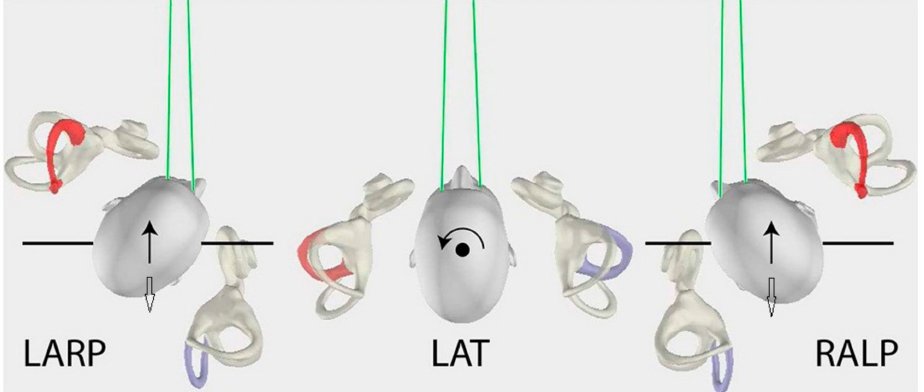
Figure 1. In the middle, affected HC (horizontal canal) plane, the head movements (circle black arrow) for left affected (red) HC/contralateral unaffected right (purple) HC, as viewed from above. On the left, affected AC (anterior canal) plane, the head movements (black arrow) for left affected (red) AC/contralateral unaffected right (purple) posterior canal (PC). On the right, affected PC plane, the head movements (white arrow) for left affected (purple) PC/contralateral unaffected right (red) AC. Inversely, on the left, affected PC plane, the head movements (white arrow) for right affected (purple) PC/contralateral unaffected left (red) AC. On the right, affected AC plane, the head movements (black arrow) for right affected (red) AC/contralateral unaffected left (purple) PC (with the permission of Curthoys IS). LARP: left anterior & right posterior canal, LAT: lateral or horizontal canals, RALP: right anterior & left posterior